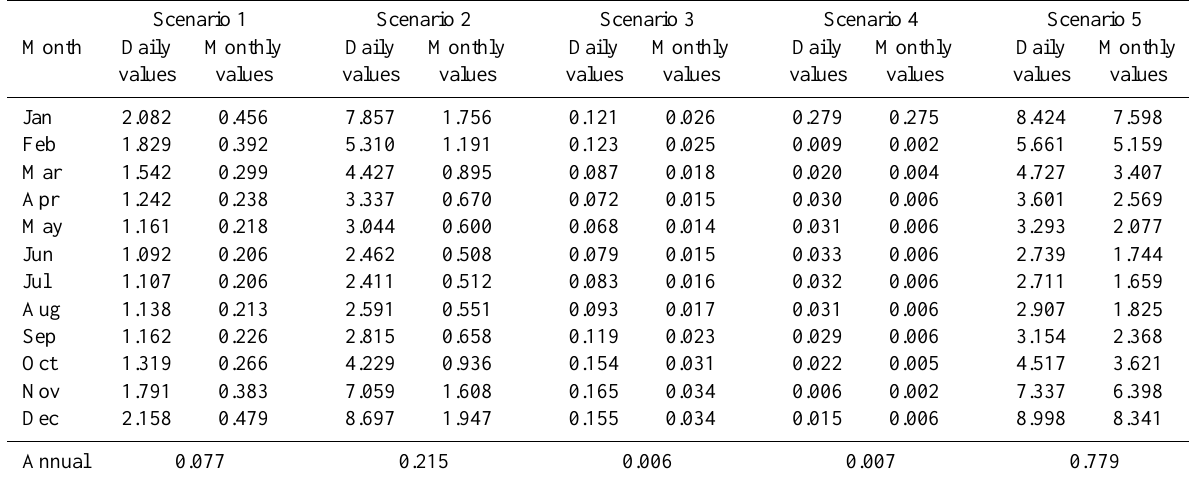
Table 7. Average errors values ET o ( ± 2 σ , %) for different time scale during the period 2004–2011 for irrigation district of Riegos del Alto Arag´on (RAA, Gra˜n´en weather